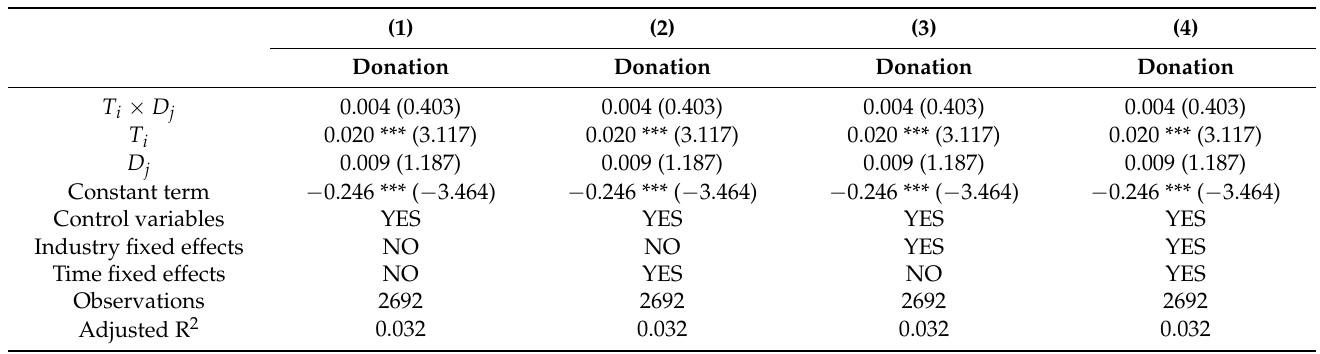
Table 5. Placebo test results.